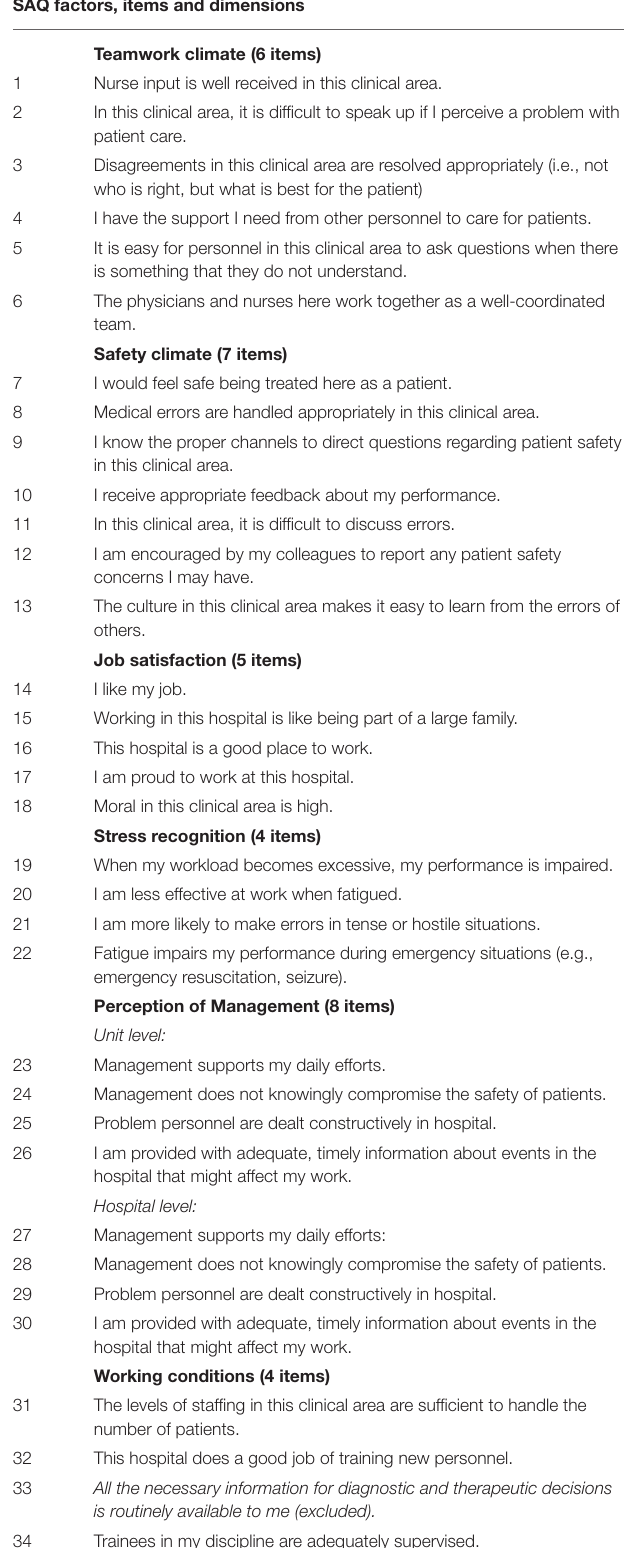
TABLE 1 | SAQ factors, items and dimensions. SAQ factors, items and